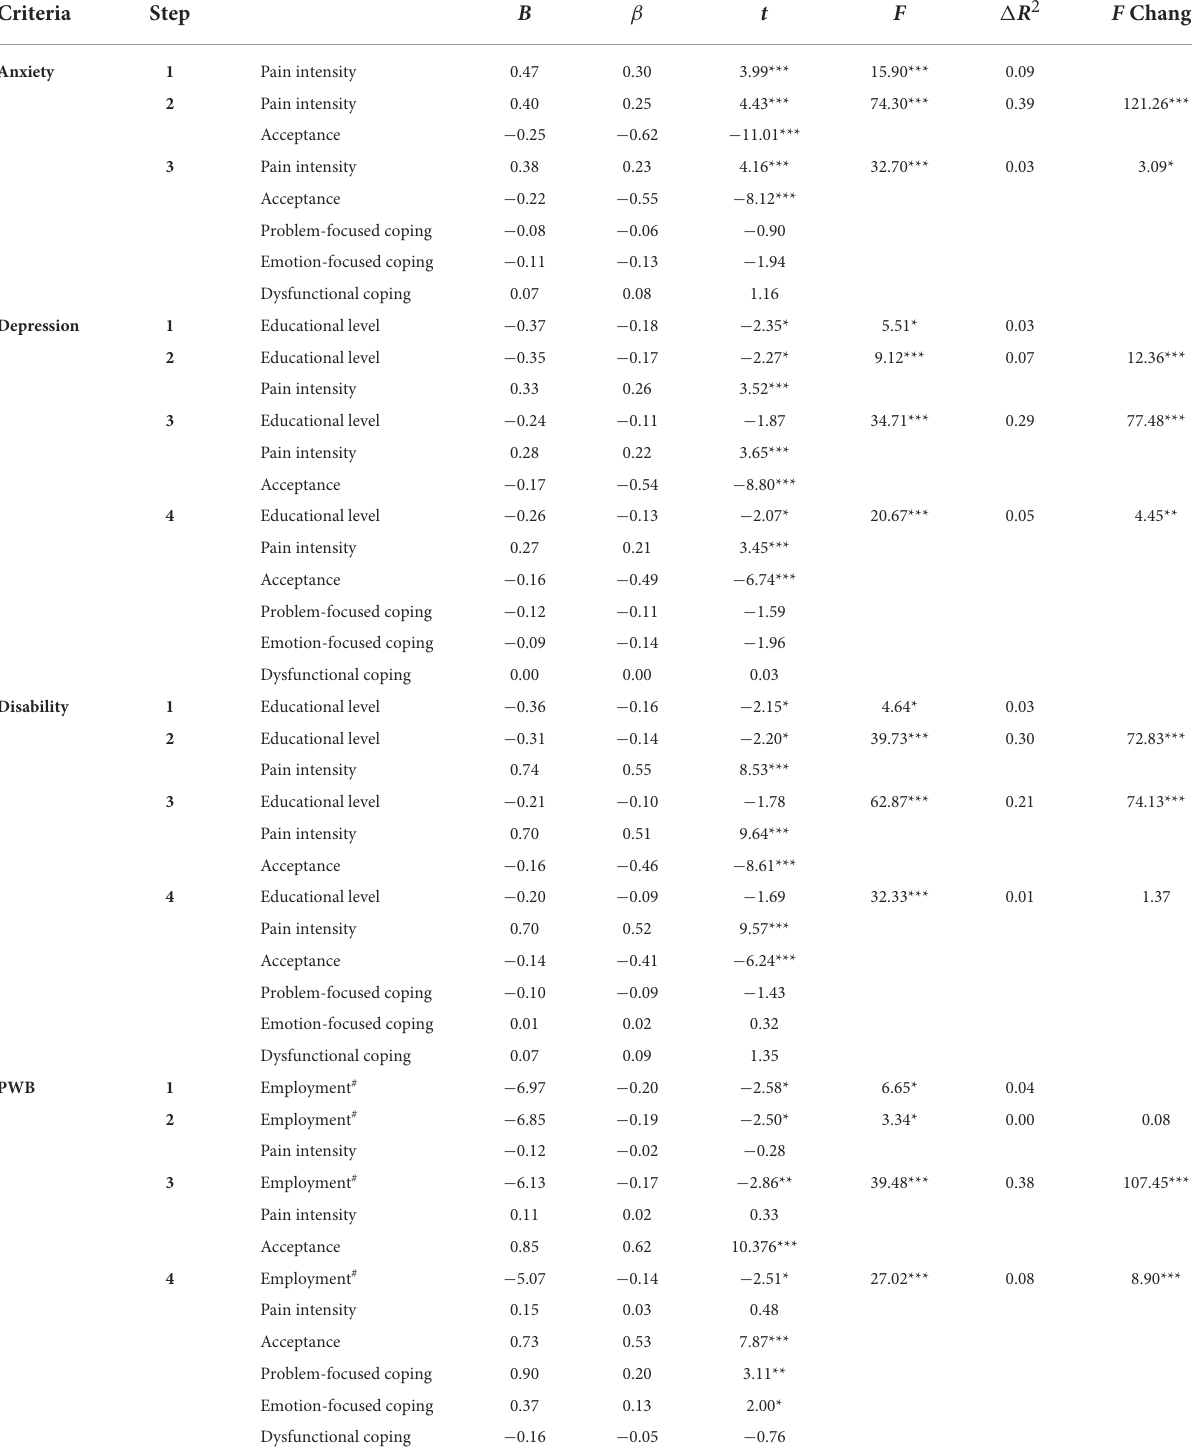
TABLE 3 HMR models to predict adjustment (when acceptance is entered before